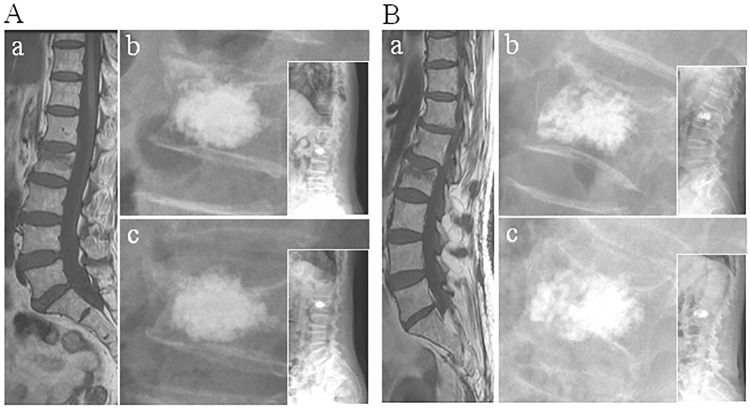
Representative MR and X-ray images of recompression and non-recompression.A: Recompression: a: MRI showed the fracture of L2. b: X-ray images taken 1 day after surgery. c: X-ray images taken 12 months after surgery. B: Non-recompression. a: MRI showed the fracture of L2. b: X-ray images taken 1 day after surgery. c: X-ray images taken 12 months after surgery. MRI = magnetic resonance imaging.